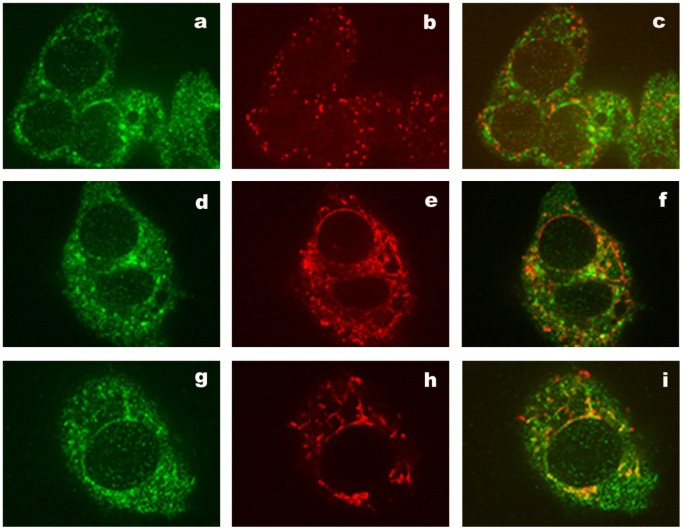
ACSVL3 immunofluorescence in HepG2 cells.Confocal microscopy was used to detect endogenous ACSVL3 in HepG2 cells by immunostaining with anti-ACSVL3 antibody (a, d, and g). Double-labeling with anti-ACSVL3 (a) and anti-PMP70 (b) demonstrated that the punctate ACSVL3-containing vesicles were not peroxisomes when the images were merged (c). Double-labeling with anti-ACSVL3 (d) and anti-protein disulfide isomerase (e) as a marker for endoplasmic reticulum revealed no colocalization in the merged image (f). Double-labeling using anti-ACSVL3 (g) and anti-ATP synthase (h) showed partial colocalization of ACSVL3 with mitochondria in the merged image (i).